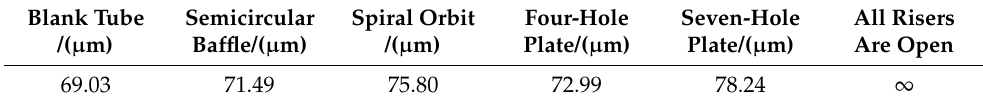
Table 1. Oil droplet